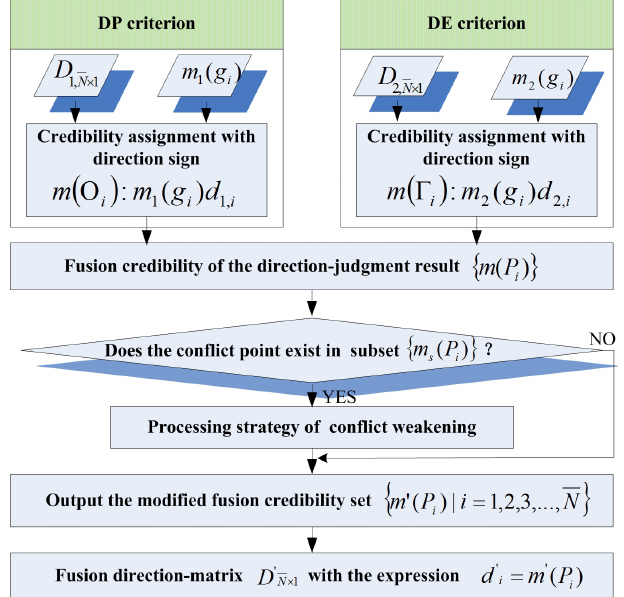
Figure 12. Basic process of credibility fusion with conflict